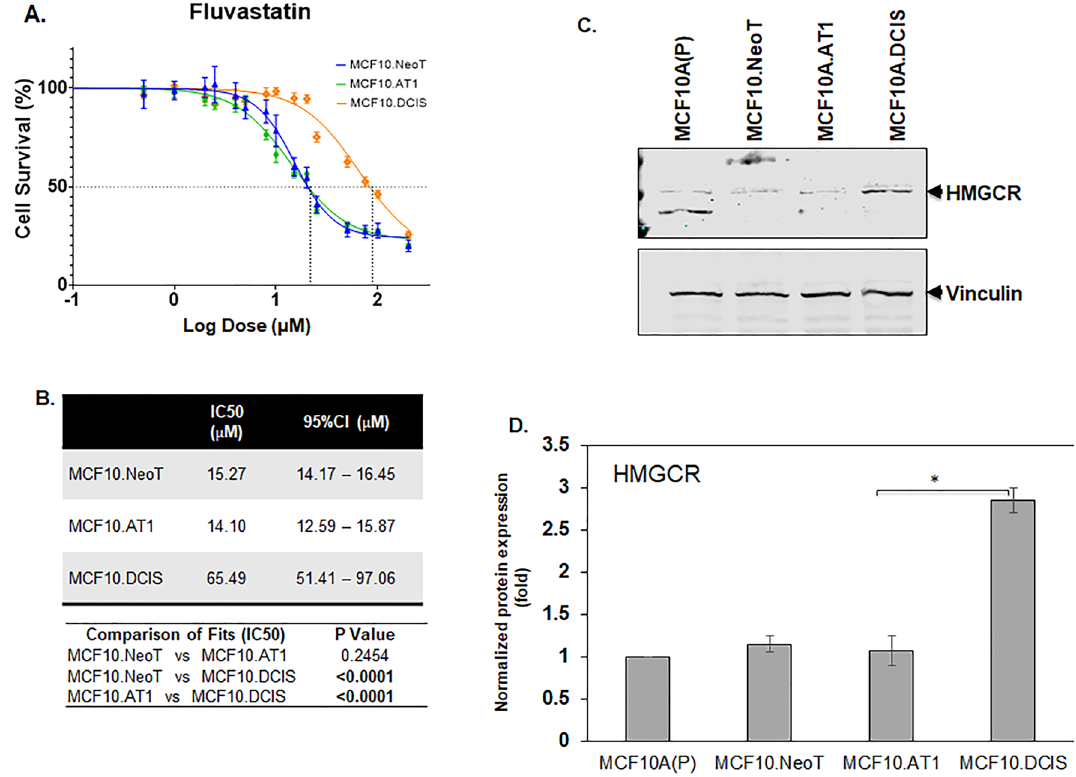
Figure 4. Aberrant activation of HMGCR at baseline is associated with lower efficacy of fluvastatin. ( A ) Cell survival curves as measured by MTT assay show inhibition in proliferation of MCF10.NeoT, MCF10.AT1 and MCF10.DCIS cells by a cholesterol-lowering drug, fluvastatin. ( B ) Table shows the IC50 and p values for each cell line. p < 0.05 was considered statistically significant. ( C ) Western blot and ( D ) its quantification shows upregulation of HMGCR in the MCF10A breast cancer progression panel. HMGCR expression was normalized to vinculin. Bar diagram: average values ± standard error of the mean (SEM). *p <